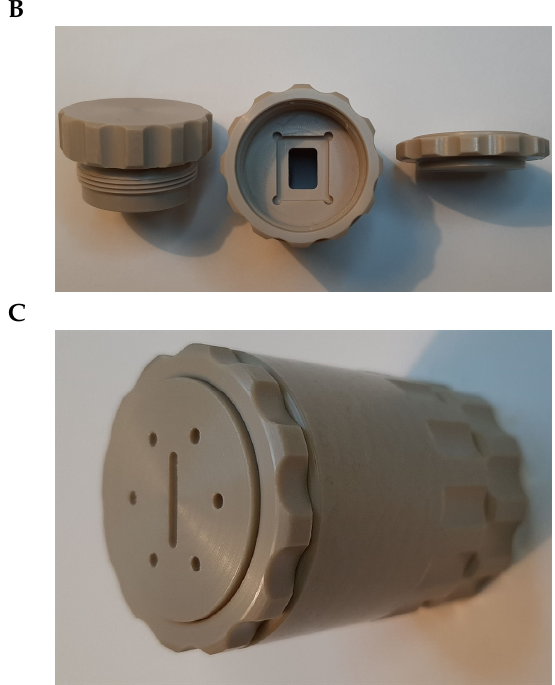
Figure 5. ( A ) the custom-made “coating chamber”: top view of a lid and a chamber; ( B ) bottom view of the “coating chamber” lid and the chamber itself, with a groove for a PDMS gasket and a gold sensor chip; ( C ) assembled “coating